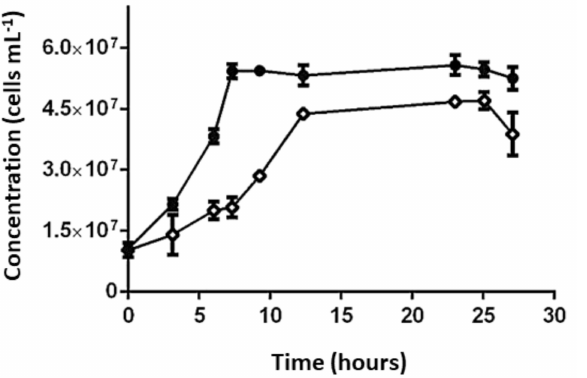
Figure 11. Cell growth of Sulfobacillus sp. CBAR13 strain growing with iron (Fe 2+ ) (black circles) and tetrathionate (white circles) as the energy source. Vertical bars represent the standard deviation (SD) calculated with biological